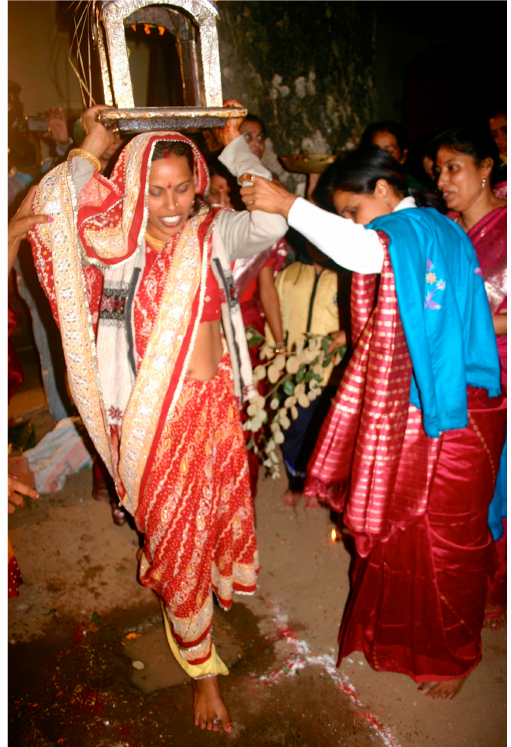
Figure 4. Crossing over the holes with a small house ( xobheri ) during K¯aty¯ayan¯ı